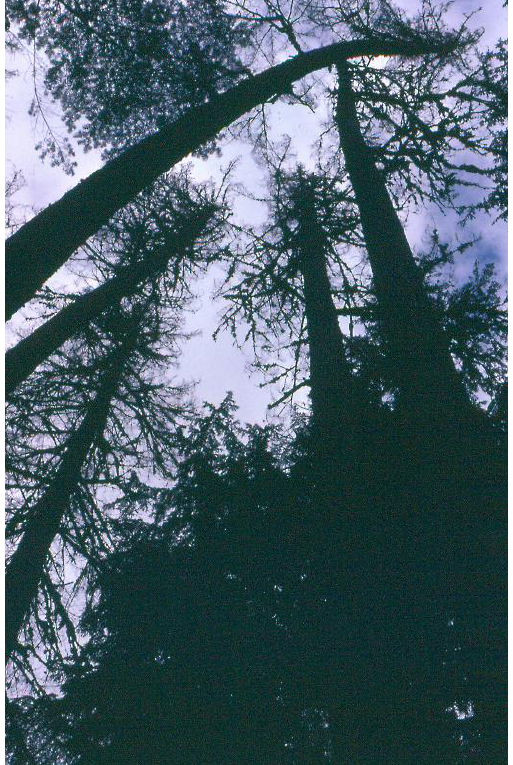
Figure 3. A dense group of six old-growth Douglas-fir trees (500-year-old) at the H.J. Andrews Experimental Forest Long-Term Ecological Research Site in western Oregon killed by Douglas-fir beetles during a drought,